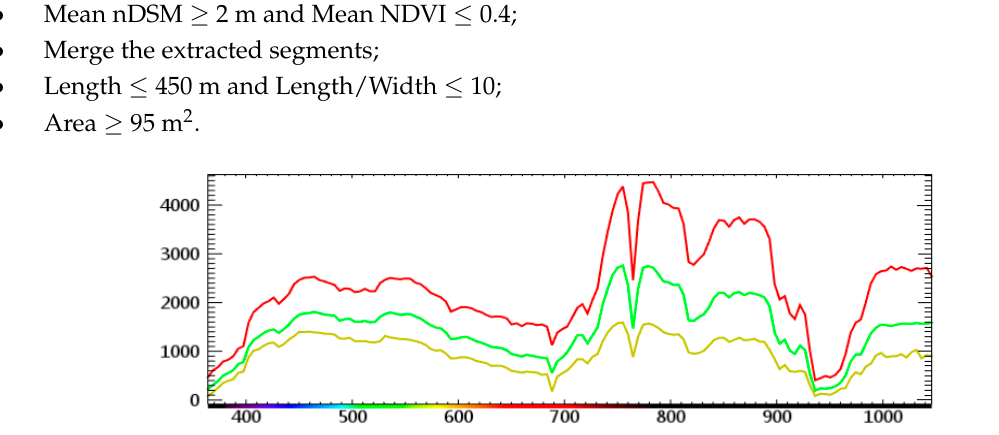
Figure 5. Spectral curve of vegetation in shadow areas. Here, red/green/yellow lines represent max/mean/min values of hyperspectral data, respectively. The longitudinal axis represents radiance, and the transverse axis represents wavelength (nm).